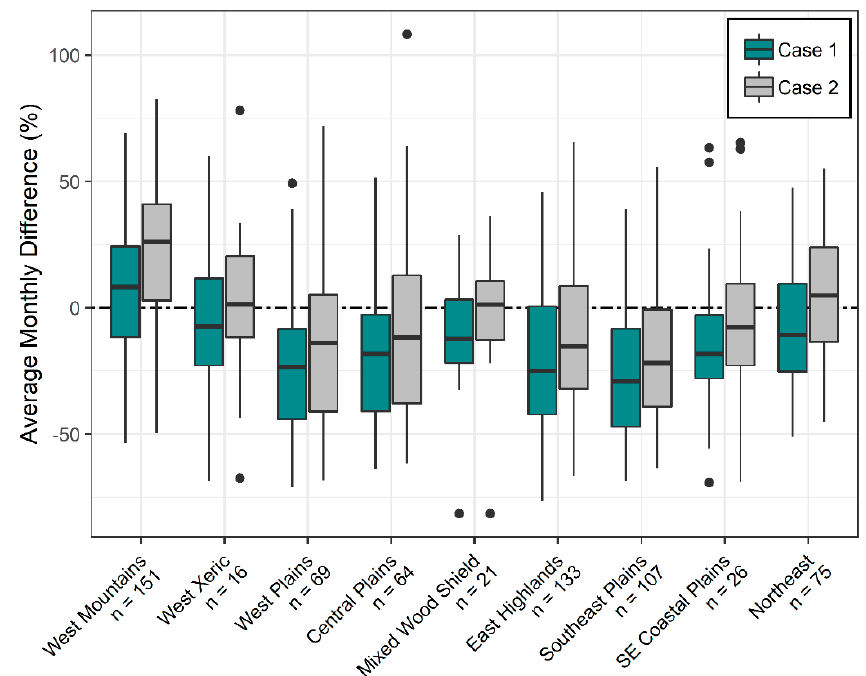
Figure 10. Average monthly di ff erence in percent contribution from GWF and OHS base flow (case 1; teal) and GWFSF and OHS base flow (case 2; grey) over aggregated ecoregions [34]. Values greater than 100 percent are due to the comparison of HRU-based volumes with routed-based stream segment volumes (n = 6 out of 662 sites). The dotted line emphasizes a zero di ff erence. One exception to this is the West Mountains ecoregion, in which all flow quartiles match well to OHS base flow with a median difference across flow quartiles ranging from 3–9% (Figure 11a).